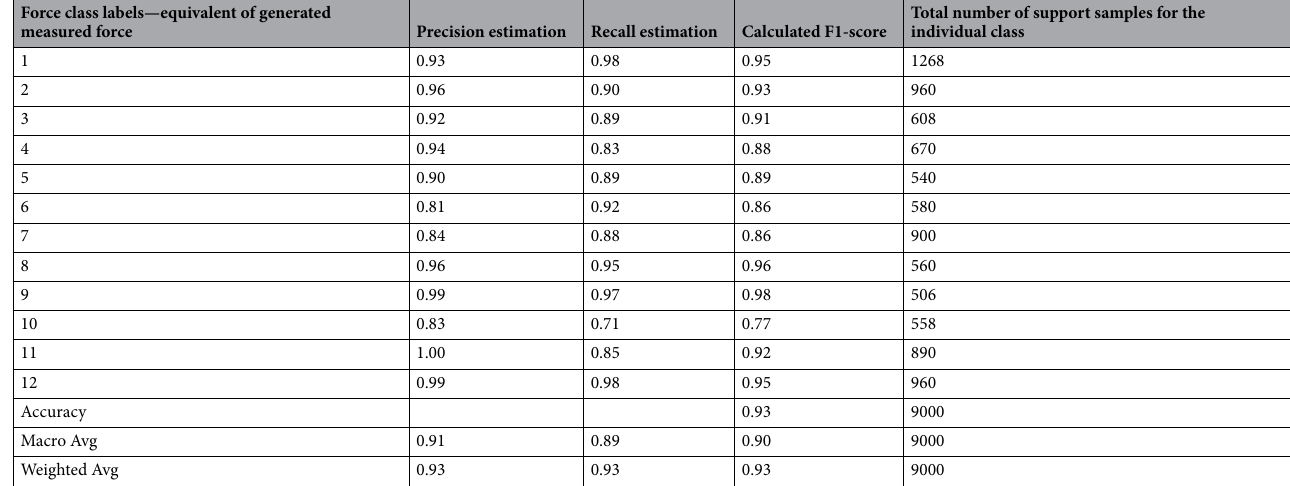
Table 2. The complete classification report for the RF based multiclass classification results including prediction accuracy, precision, recall, F1-score of classification results from the independent validation stage while predicting class labels related to the classes of generated force by the SMA body movements.